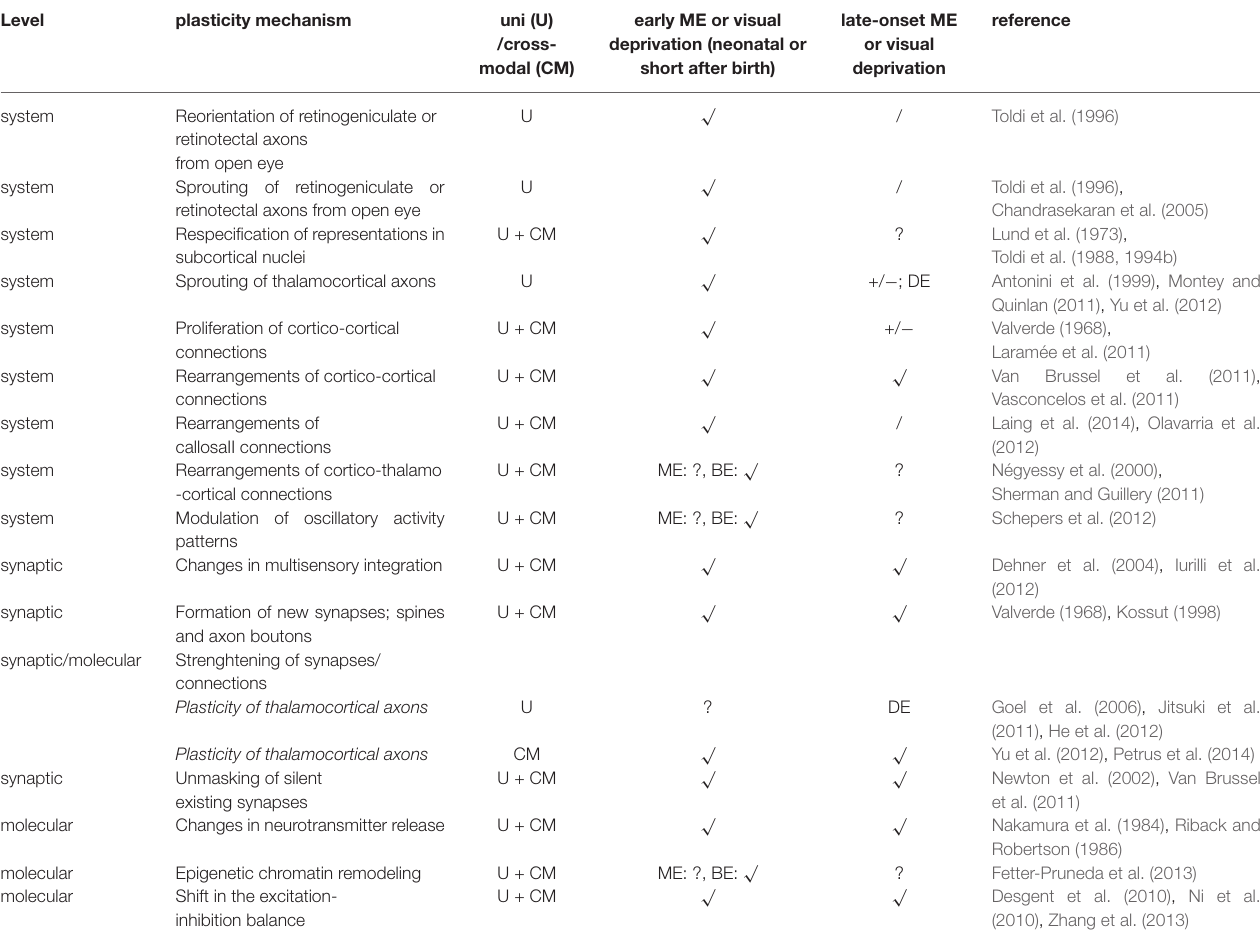
TABLE 1 | Candidate mechanisms at different levels underlying visual (U) and cross-modal (CM) plasticity following early and late-onset ME and in comparison with binocular enucleation (BE) or dark exposure (DE) effects